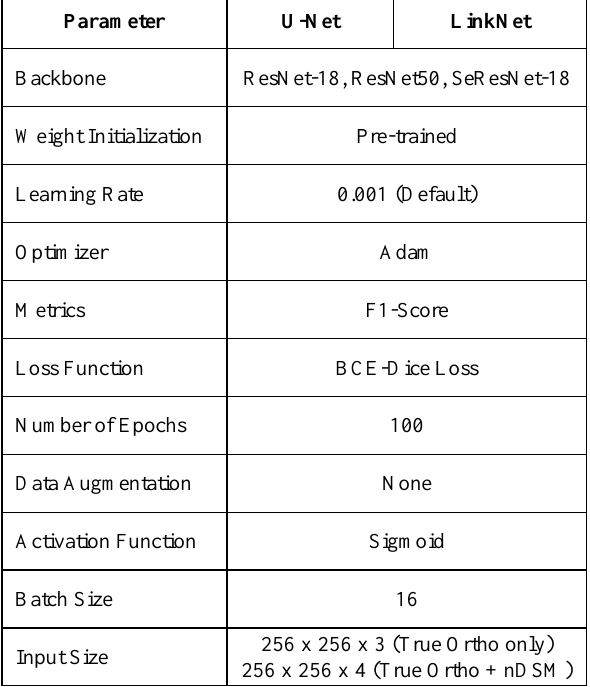
Table 1 . Model training parameters